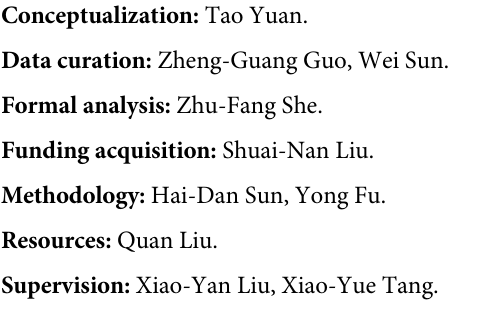
S2 Fig. Qualitative and quantitative analyses of triplicate LC/MS/MS runs. S3 Fig. The pathway analysis of BAT proteins and BAT PTM